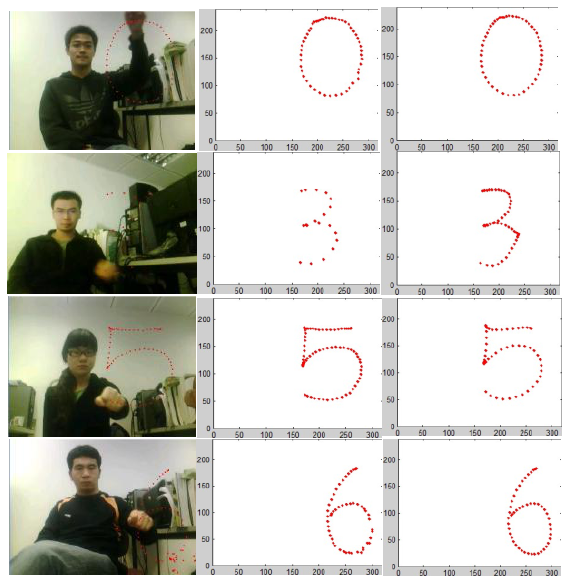
Figure 9. Examples of motion tracking. First column: last frame of gesture; Second column: selected best track; Third column: normalized